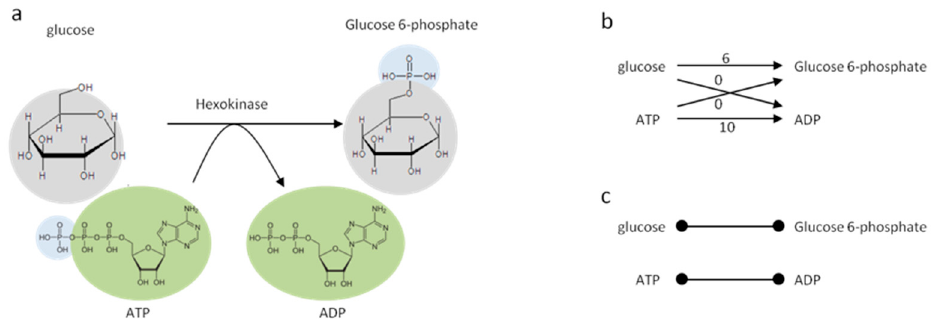
Figure 1. Graph reconstruction process. ( a ) Hexokinase reaction as described in the Recon2 database. Colored circles provide information on shared substructures between substrates and products. ( b ) Compound graph: each substrate is connected to each product of the reaction. Edges are weighted by the number of carbon atoms shared between each substrate to each product. ( c ) Final graph: transitions that do not involve the preservation of at least one carbon atom between the source and the target were removed.